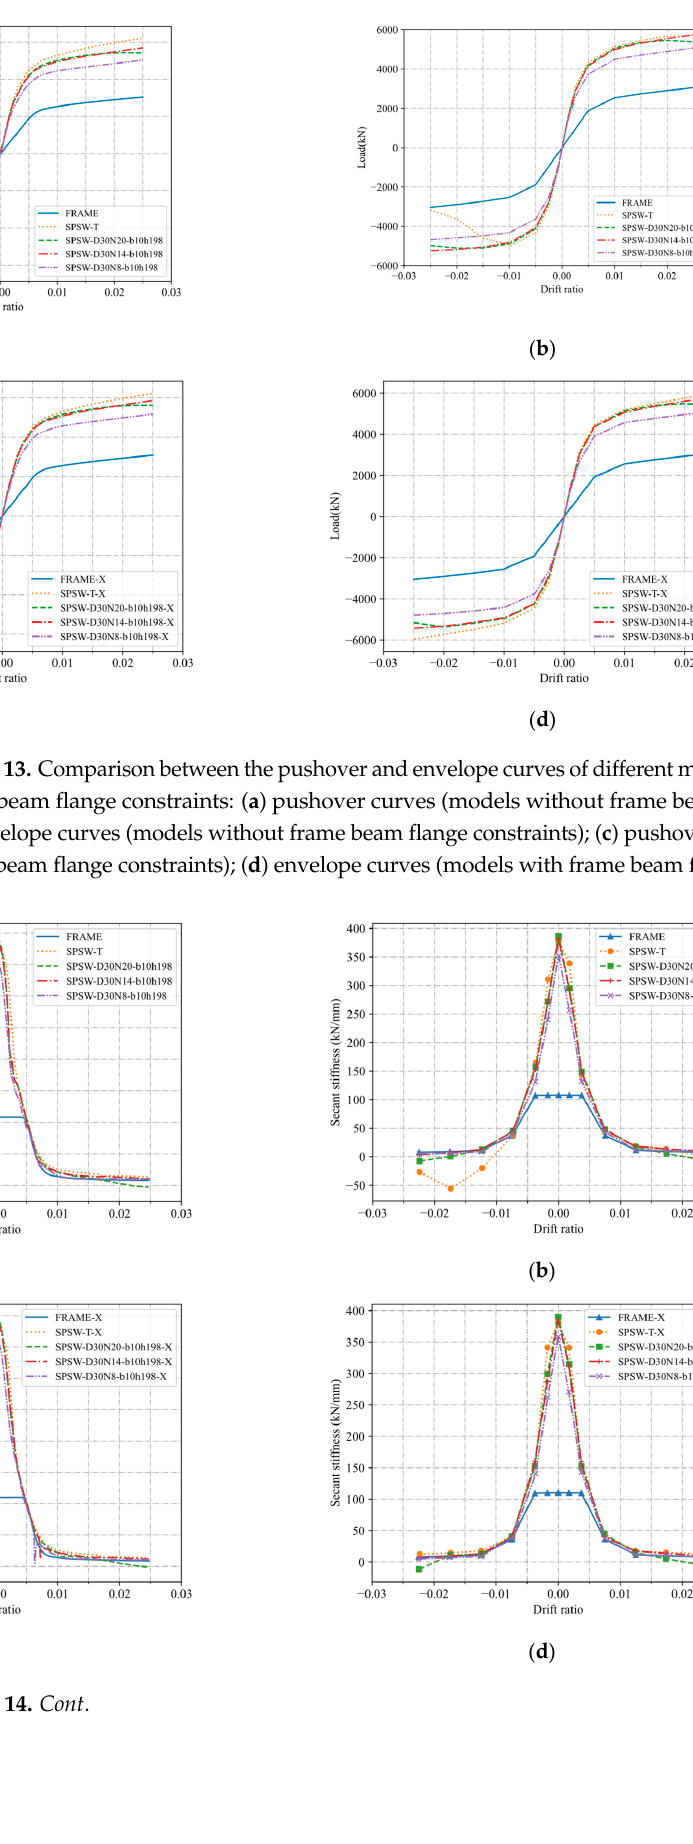
Figure 14. Comparison between the secant sti ff ness reduction curves of di ff erent models separately with and without frame beam fl ange constraints: ( a ) without frame beam fl ange constraints under monotonic loading; ( b ) without frame beam fl ange constraints under cyclic loading; ( c ) with frame beam fl ange constraints under monotonic loading; ( d ) with frame beam fl ange constraints under cyclic loading; ( e ) without frame beam fl ange constraints within the range of 0: ±5 mm of monotonic loading; ( f ) with frame beam fl ange constraints within the range of 0: ±5 mm of monotonic loading.